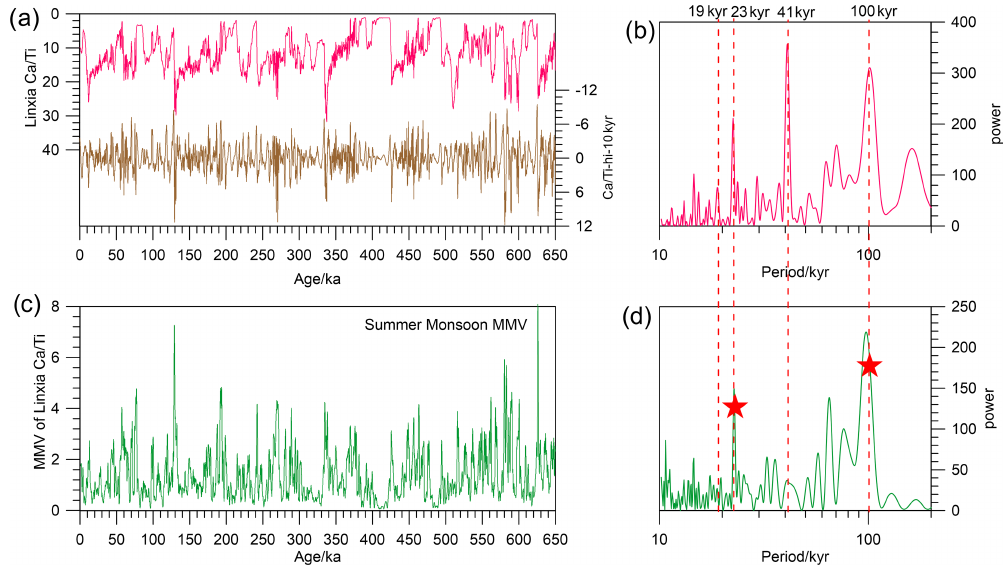
Figure 3. Raw datasets, millennial-scale components (10kyr high-pass-filtering signals) and MMV of the Linxia loess Ca / Ti record over the past 650kyr with their corresponding spectra. The orbital bands are marked with red dashed lines (eccentricity: 100kyr, obliquity: 41kyr, precession: 23 and 19kyr). Clear eccentricity, obliquity and precession variance as well as persistent millennial-scale components are observed for loess Ca / Ti and